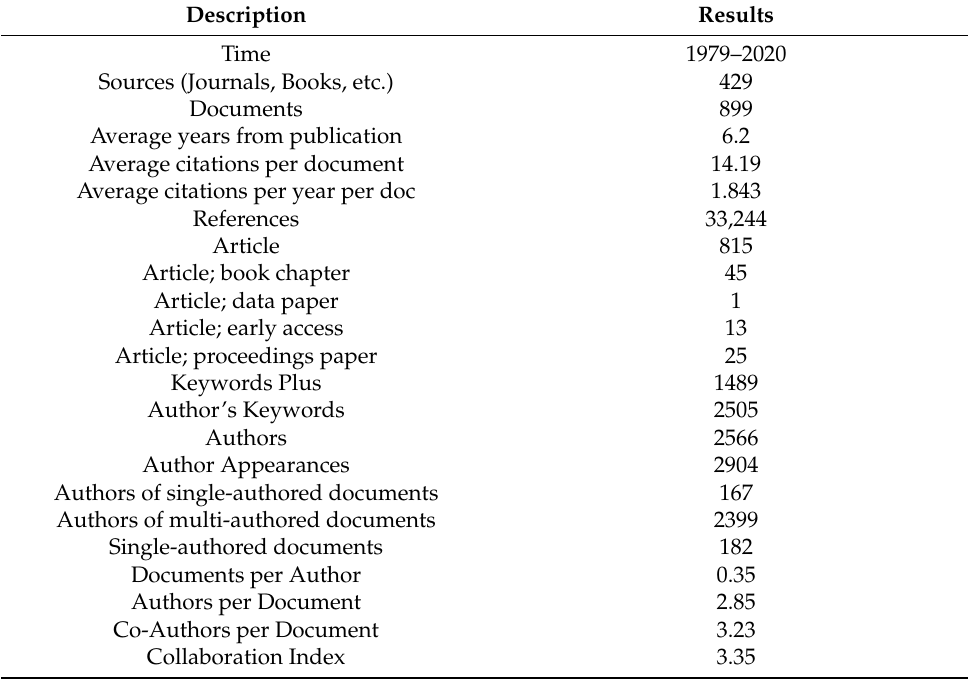
Table 1. Main information about retrieved data from the Web of